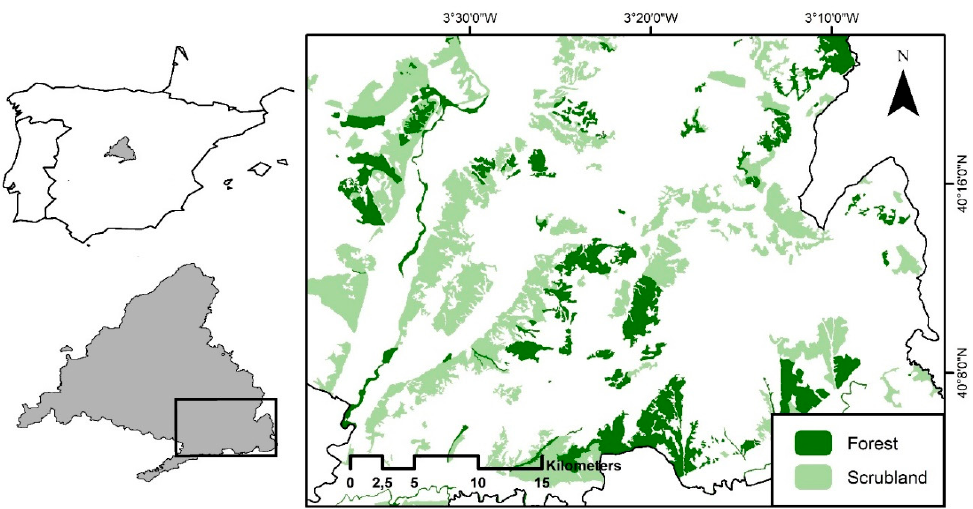
Figure 1. Location of the study area in the Autonomous Region of Madrid (grey colour, maps to the left) in Spain, Iberian Peninsula (top-left map). Characterisation of the land cover categories (map to the right) considered in this study as providers of refuge from predation for the stone marten in the study area.